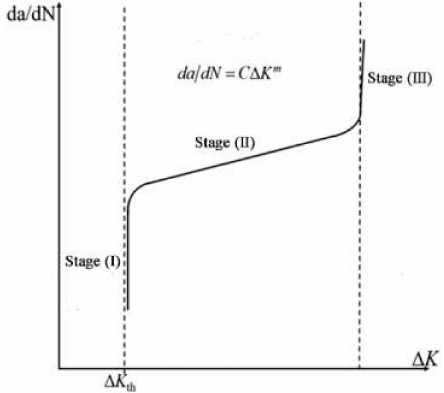
Figure 14. The diagram of the crack growth rate